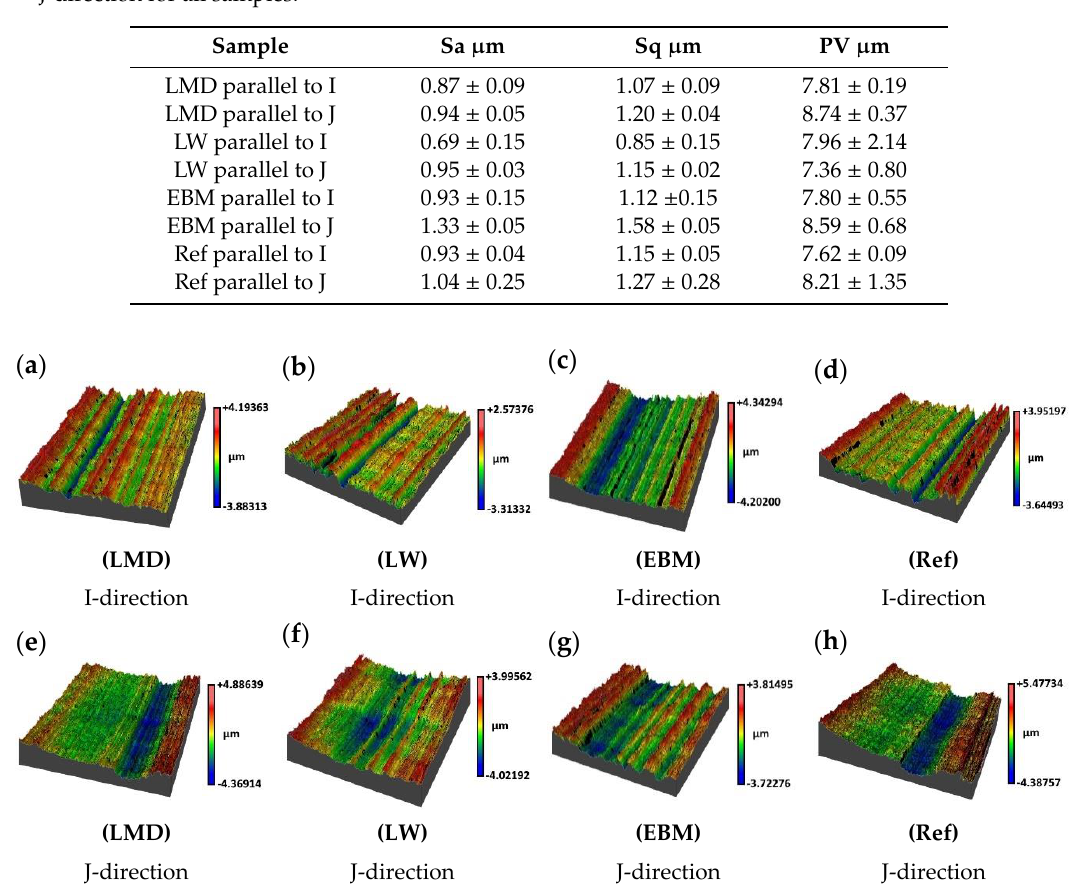
Table 8. Data of 3D surface roughness parameters: arithmetical mean height (Sa), root mean square height (Sq), and peak-to-valley (PV). These data are shown parallel to the I-direction and parallel to the J-direction for all samples.